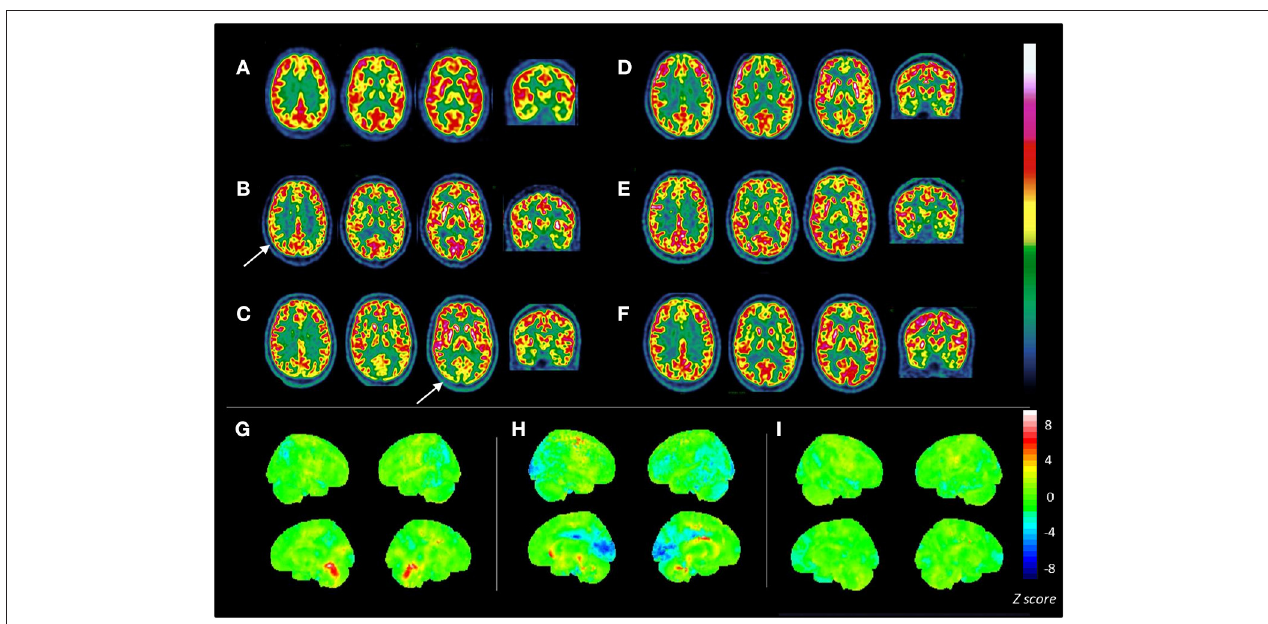
FIGURE 1 | Consecutive brain 18 F-FDG PET scans in a patient aged 16 y/o with seronegative AIE. Axial slices of 6 consecutive 18 F-FDG PET scans (A–F) are displayed in radiological view with the French scale color. (A) First 18 F-FDG PET: moderate mediofrontal and thalamic hypometabolism; 18 F-FDG PET was performed after the first plasma exchange, when the patient’s state was slowly improving. (B) Second 18 F-FDG PET: moderate, bilateral parietotemporal hypometabolism (white arrow); bilateral striatal hypermetabolism; metabolism is significantly decreased compared with healthy controls in the posterior cingulate and parietotemporal cortices with Z-scores ranging from − 2.1 to − 2.9, and highly increased in the striatum ( Z -score: + 3.5) and cerebellar vermis ( Z -score: + 3.3) (G) ; 18 F-FDG PET was performed after the second plasma exchange that was ineffective. (C) Third 18 F-FDG PET: deeper and widespread metabolism decreases in posterior cortex spreading to the primary visual cortex with Z -scores ranging from to − 2.1 to − 5.1 [in blue (H) ]; striatal hypermetabolism [in red (H) ]; deterioration of patient state; 18 F-FDG PET was performed after the third plasma exchange that was inefficient. (D) Fourth 18 F-FDG PET: partial improvement in posterior ( Z -score: − 2.3) and primary visual area metabolism ( Z -score of − 2.1 vs. a previous score of − 5.1); occurrence of moderate mediofrontal and hippocampal hypometabolism; 18 F-FDG PET was performed when the patient improved after rituximab, levodopa, ECT, and benzodiazepine administration. (E) Fifth 18 F-FDG PET: normalization of bilateral posterior associative metabolism; normalization of striatal metabolism; stability of mediofrontal and mesiotemporal hypometabolism; 18 F-FDG PET was performed when the patient was much improved, showing minor frontal syndrome and little abnormal movement. (F) Last 18 F-FDG PET: examination showing mild, persistent mediofrontal and mesiotemporal hypometabolism; normal metabolism in the posterior cortex [as shown on the statistical map (I) ]. (G–I) Show 3D statistical maps of voxel-based analyses for 3 18 F-FDG PET scans ( B,C,F , respectively) in comparison with a control group < 40 y/o ( n = 23, mean age 30.9 ± 8.6 y/o; Scenium software, Siemens healthcare). Rainbow color scale indicates Z -score values. Medial and lateral 3D views of the right (R) and left (L) hemispheres are